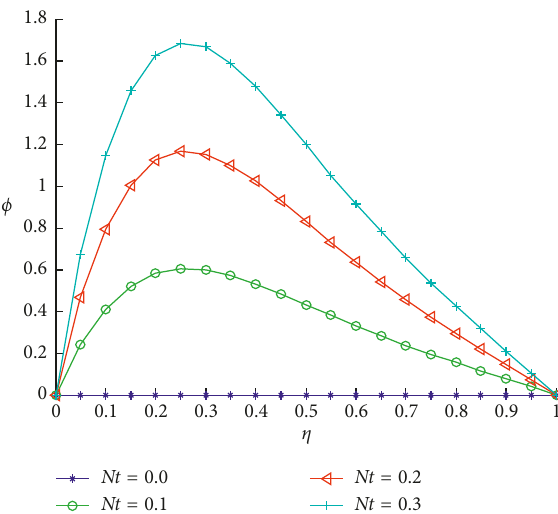
Figure 18: Effect of the squeeze parameter on the concentration profile when A Pr 1 . 0 , and C (cid:31)